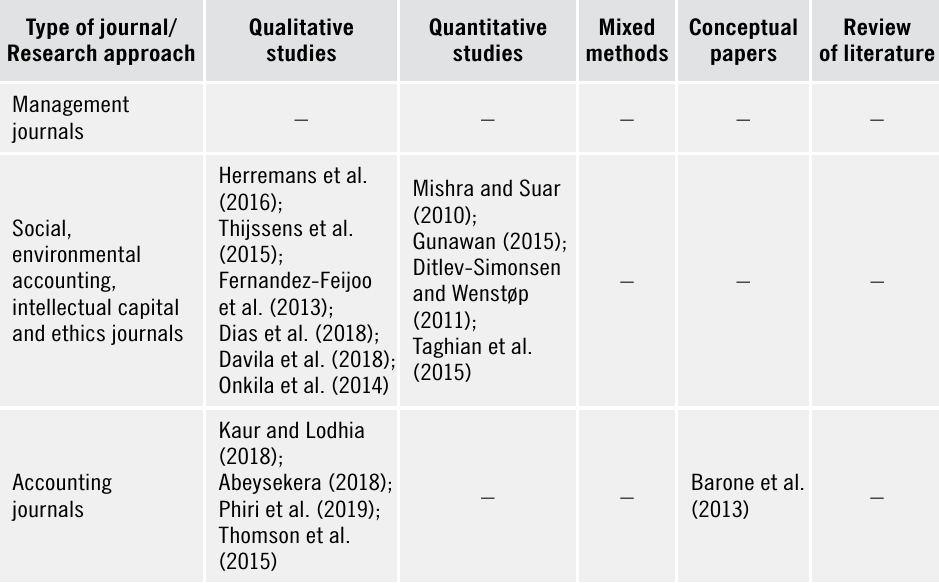
Quantitative Mixed Conceptual Review of studies methods papers